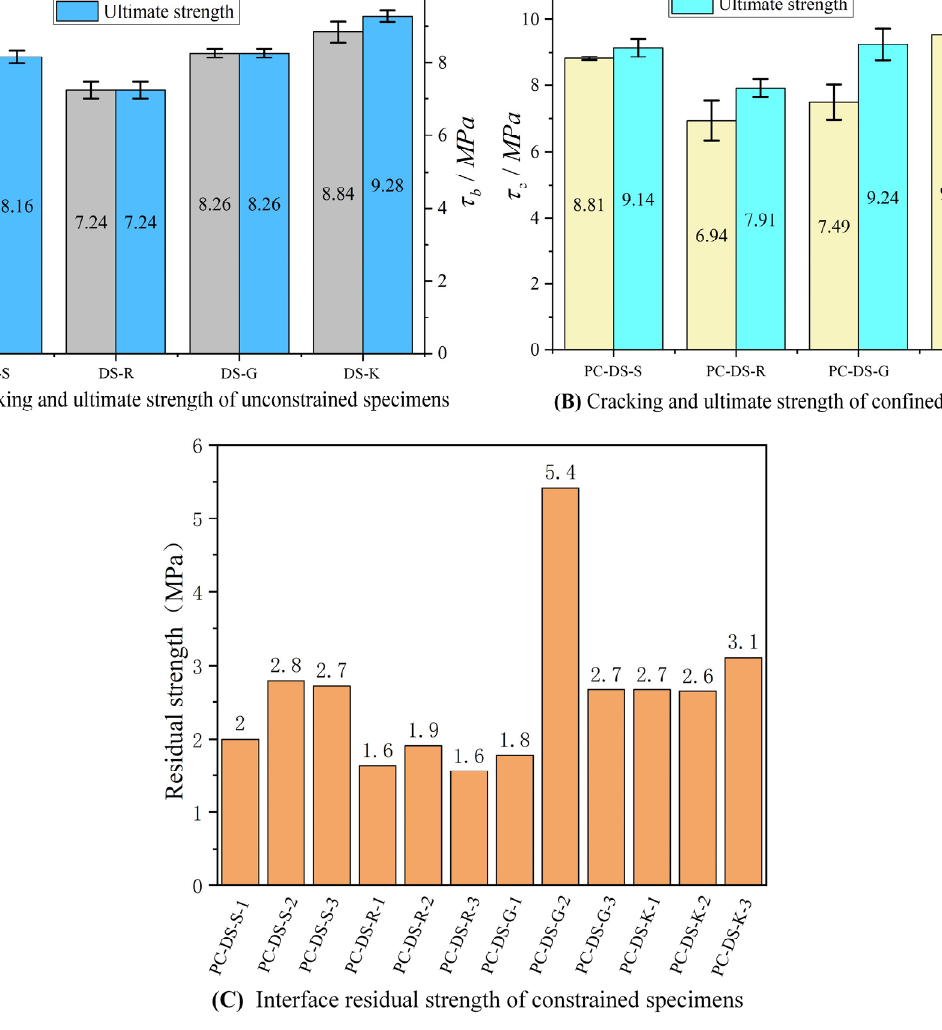
Figure 7. Interface Cracking, Limit, and Residual Strength. Table 4. Loading results of specimens.